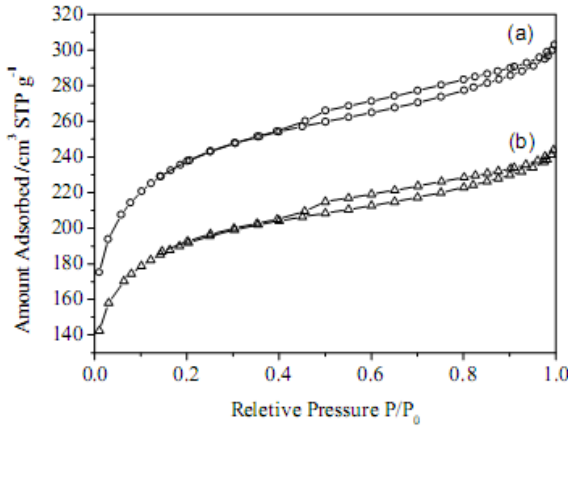
Figure 4. N adsorption isotherms of (a) AC and (b) AC-SO 2